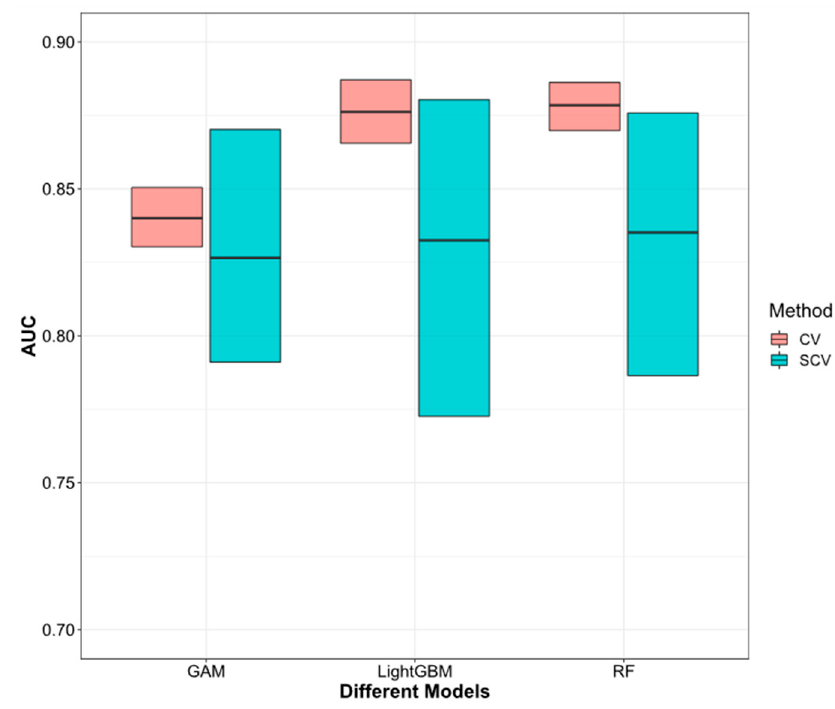
Figure 5. The CV and SCV of different models. Table 5. Predictive performance of the models on CV and